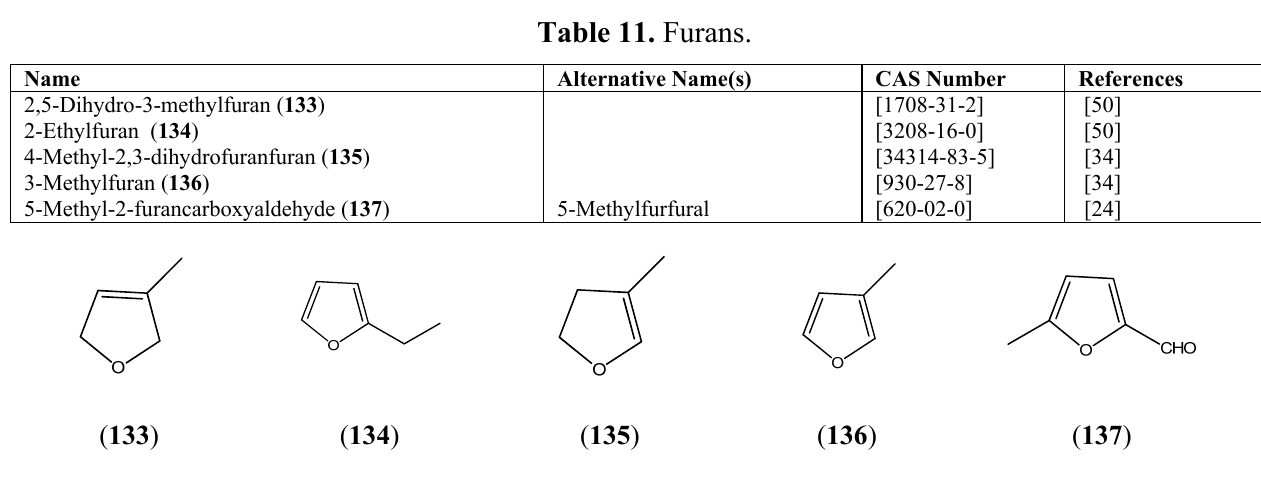
Table 11. Furans.